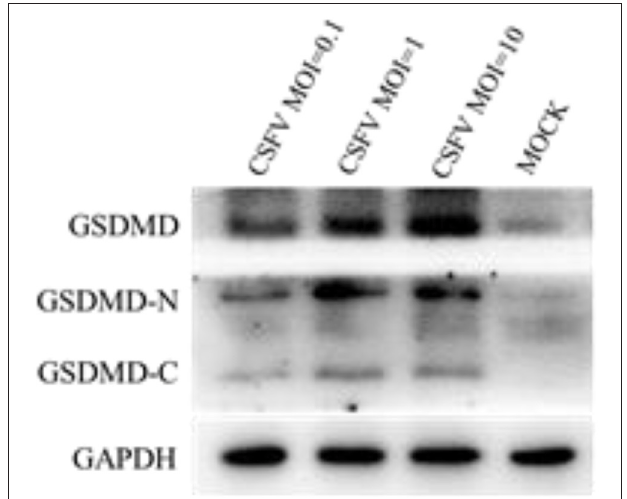
FIGURE 4 | CSFV infection induced the production and cleavage of GSDMD in PBMCs. PBMCs were mock-infected or infected with CSFV (MOI of 0.1, 1, or 10). The expression levels of GSDMD, GSDMD-N, and GSDMD-C were determined by western blotting at 48h pi. GAPDH was used as an internal loading